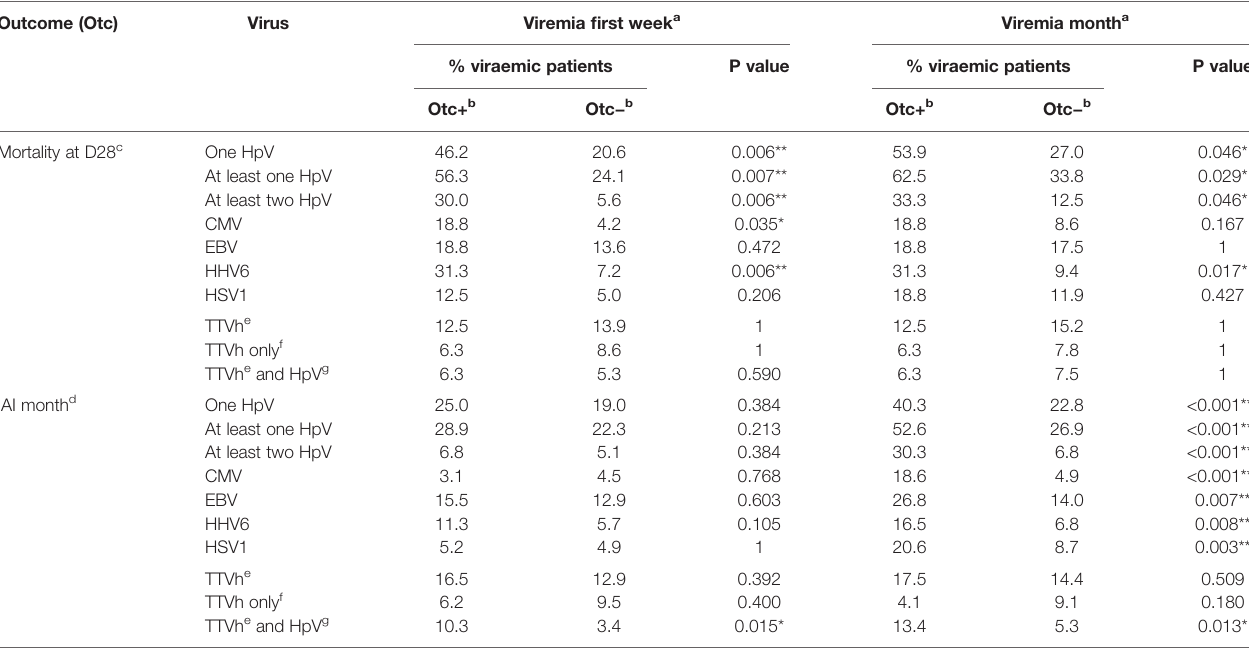
TABLE 3 | Association between binary clinical outcomes and viremia presence. Outcome (Otc)